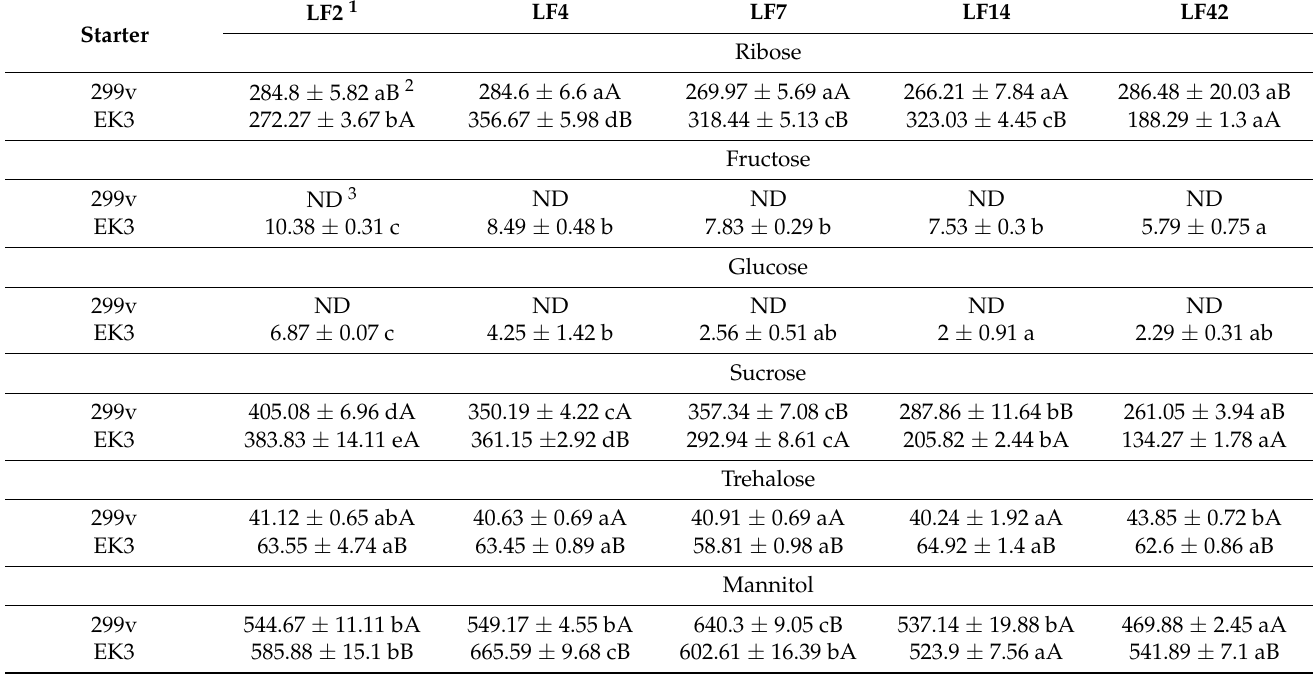
Table 4. Content of free sugars and mannitol in brine (mg/100